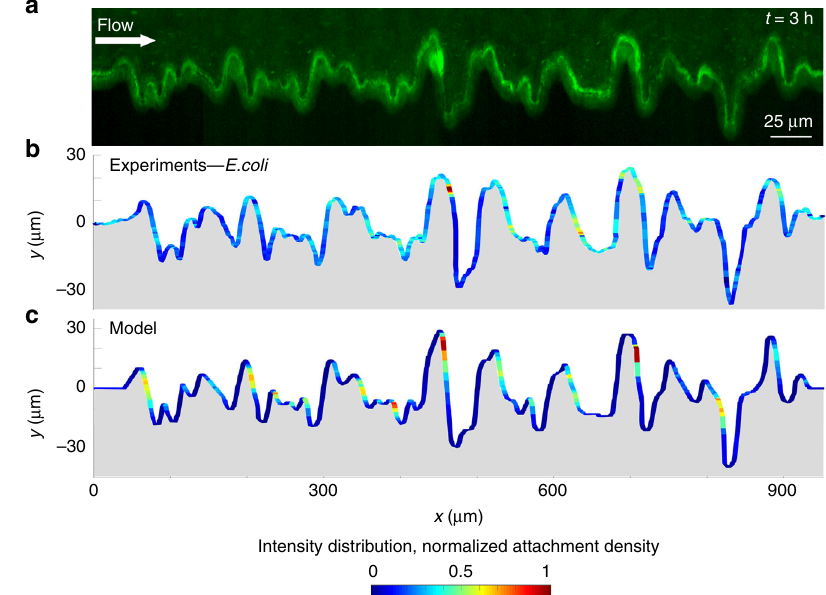
Fig. 8 Colonization of a randomly corrugated surface by E. coli . a Fluorescent image acquired at channel mid-plane of GFP-tagged E. coli wt cells attached to the lateral corrugated surface of a micro fl uidic channel (height = 100 µ m) after 3 h of fl ow of a diluted bacterial suspension at a mean fl ow velocity of U = 150 µ m s − 1 . b Intensity distribution of the fl uorescent signal shown in a , normalized by its maximum value. c Normalized attachment density of cells (elongation q = 8.5, swimming speed V = 21.6 μ m s − 1 ) on the corrugated surface obtained with the model at a mean fl ow velocity of U = 150 µ m s − 1 ( U/V =